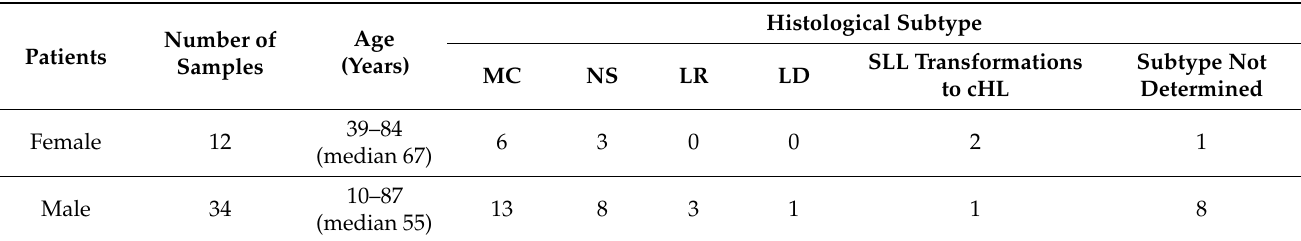
Figure 1. Most EBV-positive cases were mixed-cellularity (MC) and nodular sclerosis (NS) cHL subtypes. (HE-hemalum eosin; EBER ISH - in situ hybridization for detection of EBER , positive cells are stained blue, LMP1 IHC-immunohistochemical staining for detection of LMP1, positive cells are stained brown). Microscope’s magnification: 400 × . Table 1. EBV-positive patients with classical Hodgkin lymphoma (cHL).